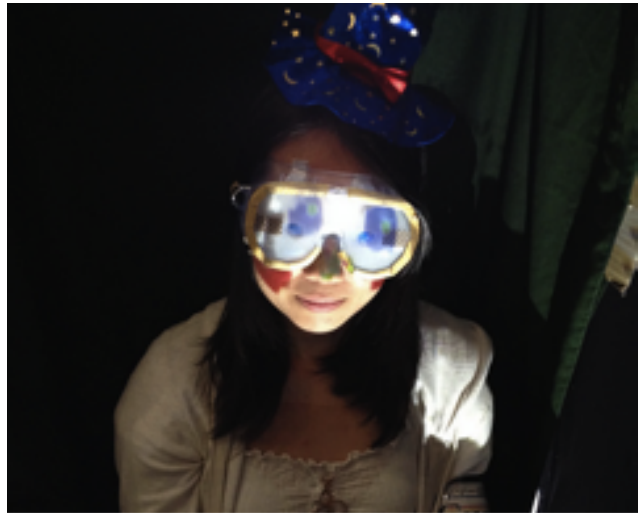
Fig. 4. A photo taken during the demonstration at International Collegiate Virtual Reality Contest